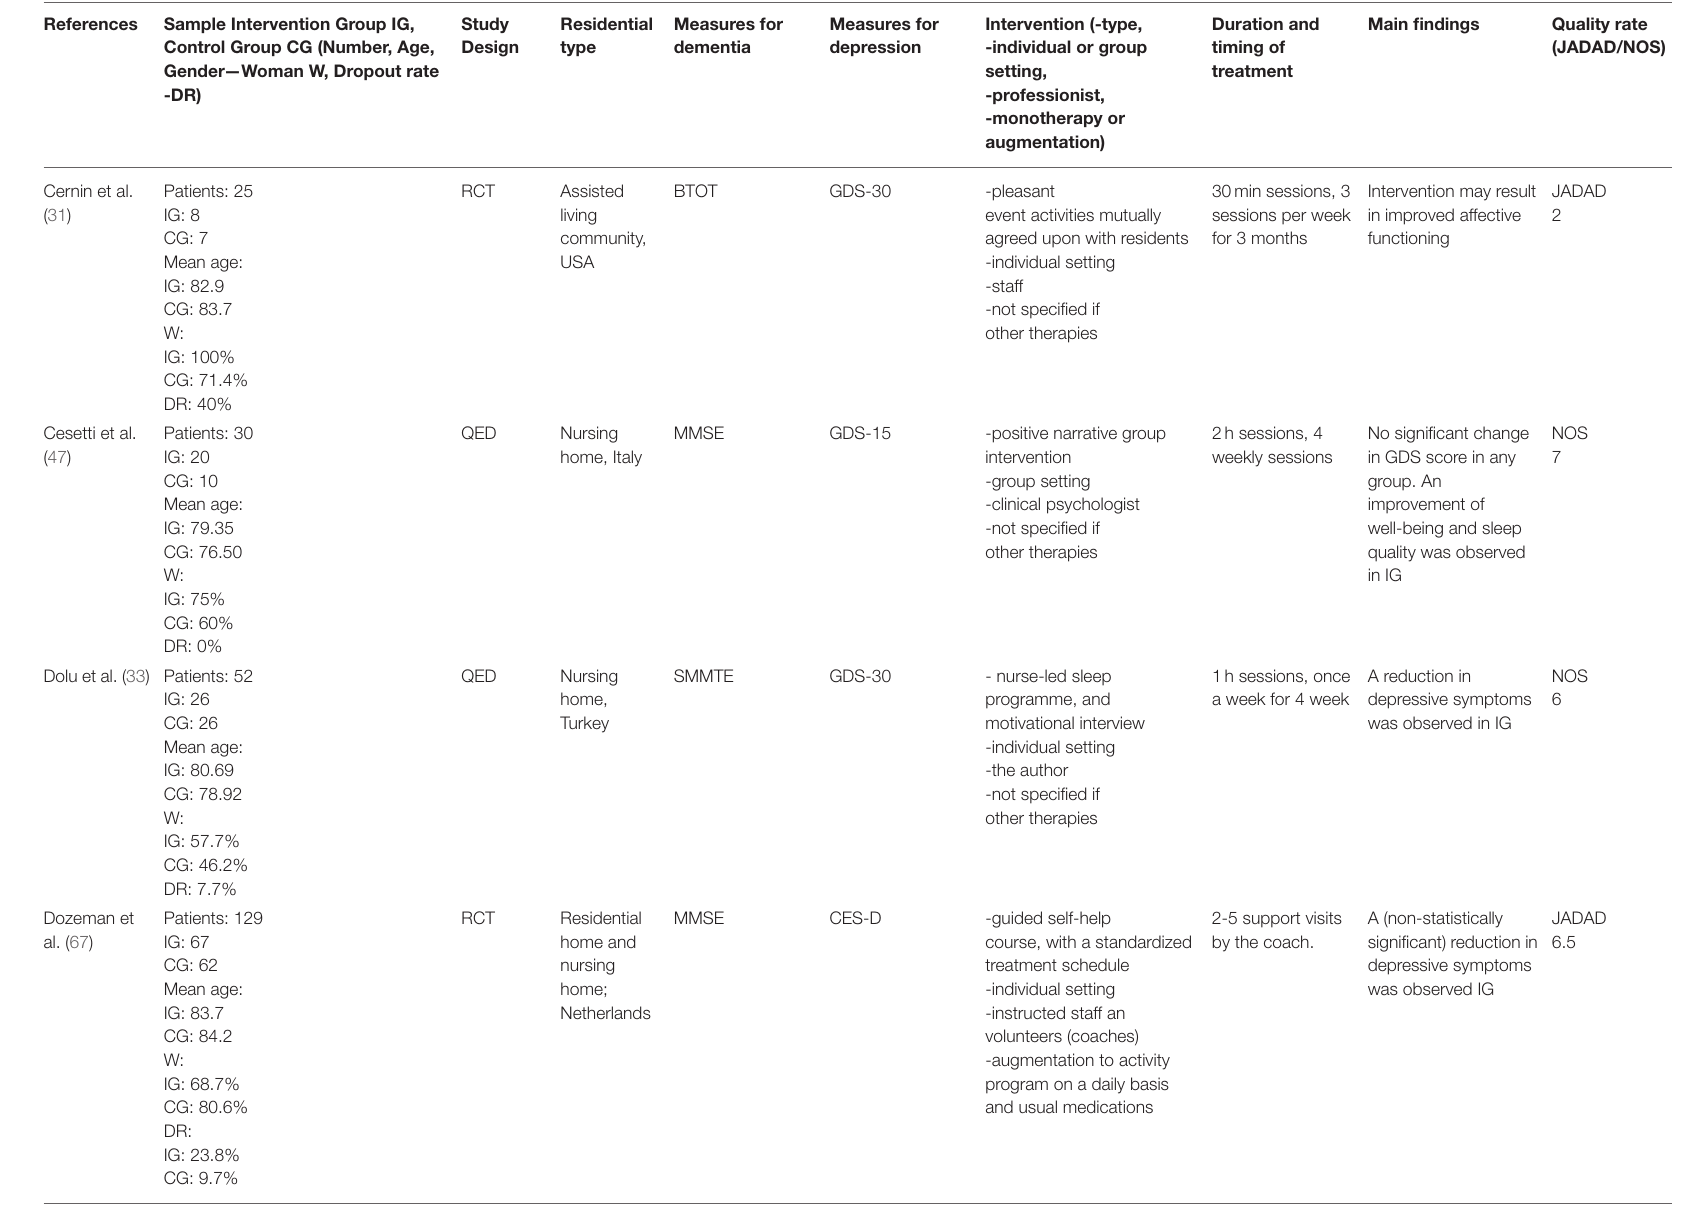
TABLE 4 | Psychoeducative/Rehabilitation Interventions studies (n 15